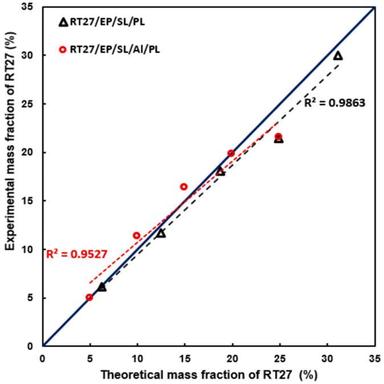
Experimental and theoretical mass fraction of paraffin into plaster composite.